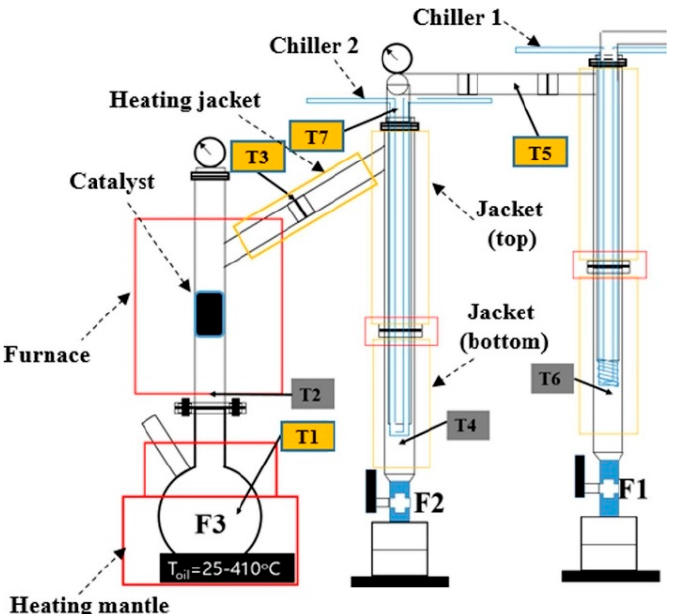
Figure 5. Schematic diagram of a laboratory pyrolysis oil separation system , reproduced with permission from [116] .